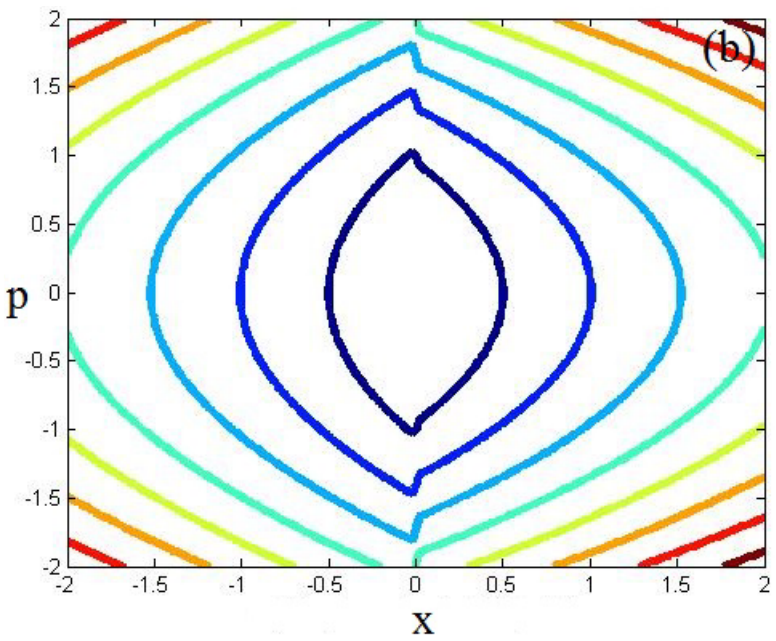
Figure 15. Phase portrait of the PDM Hamiltonian associated with Rath potential for ( a ) λ = 0.01 and ( b ) λ = 0.1.